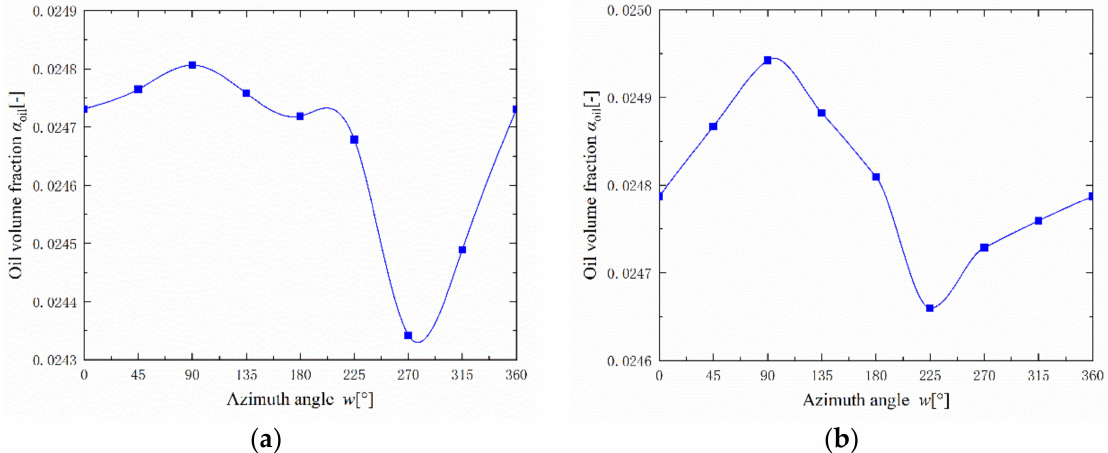
Figure 14. Oil volume fraction of gear tooth surfaces: ( a ) driving gear; ( b ) driven